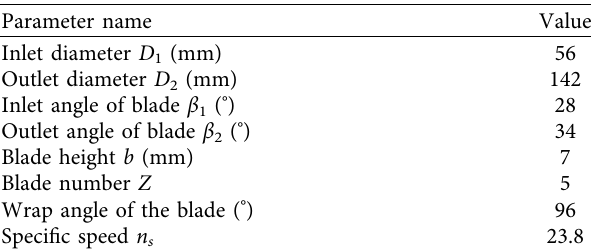
Figure 2: (a)Middle span of the impeller and definition of velocity distribution, (b) shoot section of the impeller, and (c) calculation point of slip Table 1: Main design parameters of experimental pump.